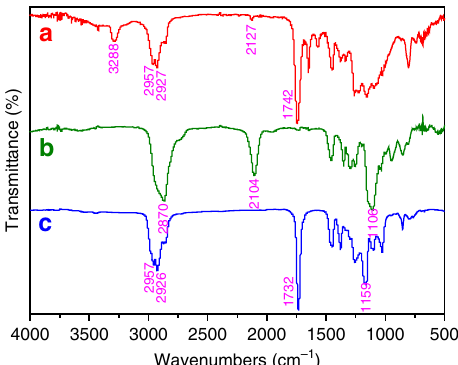
Fig. 2 Chemical structure of polymers. Fourier transform infrared (FT-IR) spectra of PBAA 4 ( a ), PEO-N 3 ( b ) and PA- g -PEA/PEO 5 asymmetric molecular double-brush ( c ).